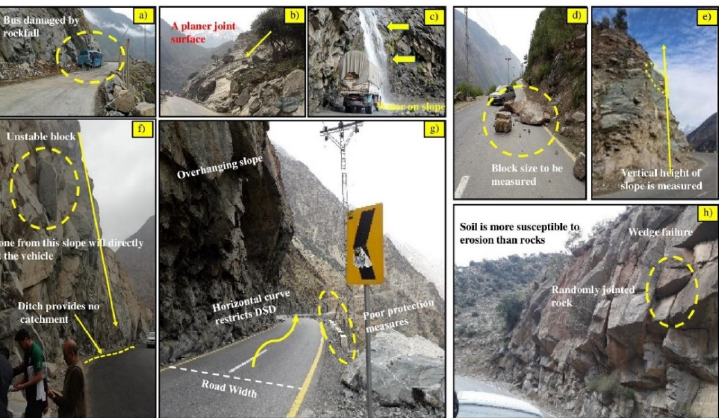
Figure 6. An overview of the measurement of field parameters for the RHRSP model. ( a ) A bus was damaged by a rockfall in the Kohistan district. ( b ) A planar joint surface. ( c ) Continuous water on the slope is a source of constant disruption of the road. ( d ) block size or volume per event is measured in the field. ( e ) Vertical height of the slope is measured rather than slope length. ( f ) Hanging block will directly hit the vehicle or human from a steep slope with an ineffective ditch. ( g ) Overhanging slopes and sharp horizontal curves restrict the Decision Sight Distance (DSD). ( h ) Multiple fracture sets are measured in the field. Soils are more susceptible to erosion. Wedge type is a common mode of